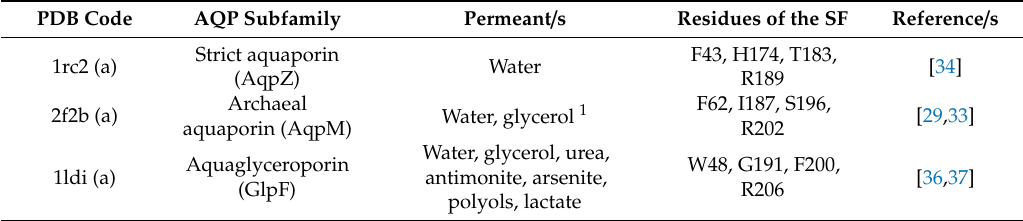
Table 1. Summary of aquaporin structures used for the calculations.